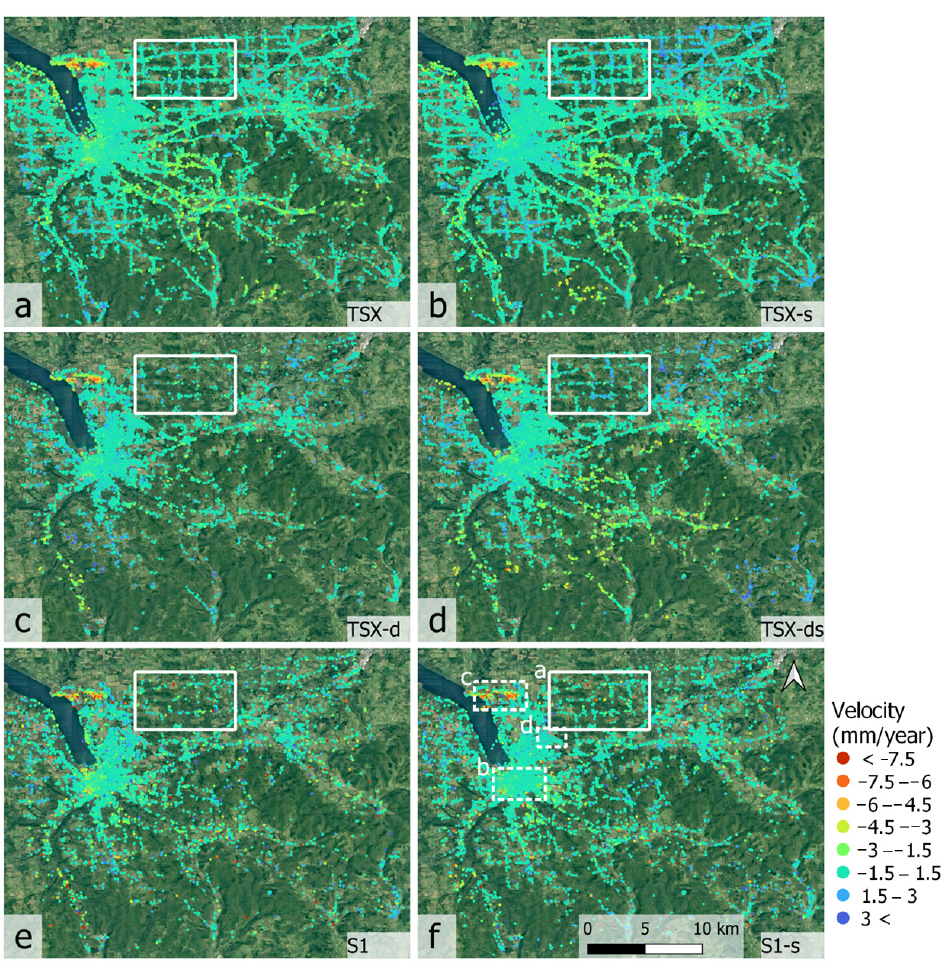
Figure 3. PS points extracted by StaMPS using the TSX ( a ), TSX-s ( b ), TSX-d ( c ), TSX-ds ( d ), S1 ( e ), and S1-s ( f ) datasets colored according to the inferred average displacement rate in the vertical direction between 2018 and 2021 with the assumption that all InSAR-observed change was associated with vertical displacements. The labeled white boxes in ( f ) are the same as in Figure 1 but with the addition of ( d ) for the airport region and show areas displayed in Figures 4–6. Basemap imagery available through Google: imagery @2023 TerraMetrics; map data @2023. The white box with the solid outline in Figure 3 (labeled “a” in Figure 3f) indicates a portion of the study area that was dominated by vegetation and agricultural fi elds with few roads. The PS points in this area were clustered along the isolated houses and along roads.